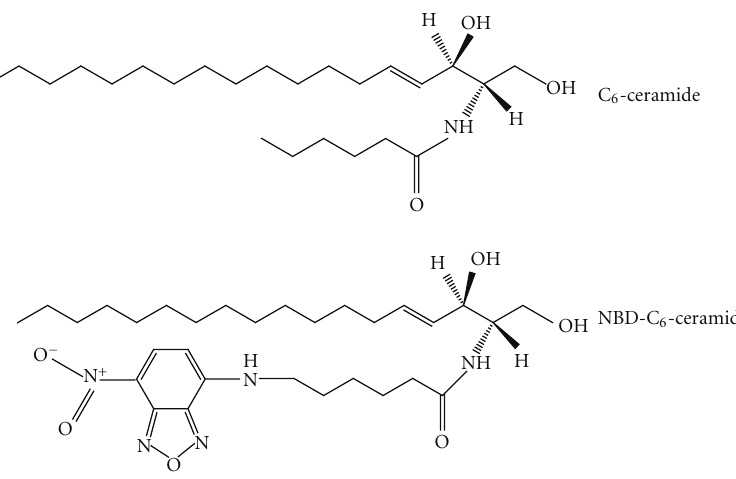
Figure 1: Structure of C 6 -ceramide and NBD-C 6